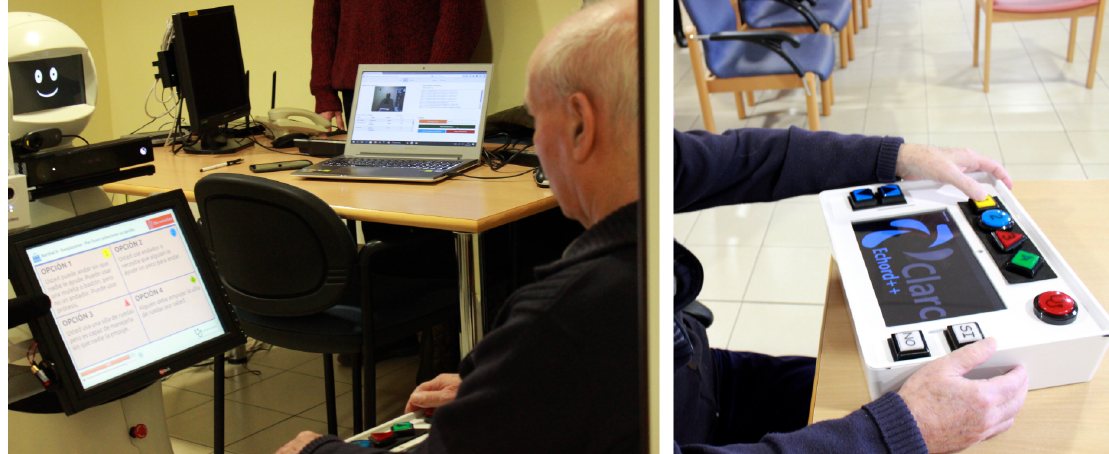
Figure 1. ( Left ) CLARC interacting with a patient for performing a Barthel test. ( Right ) The external remote